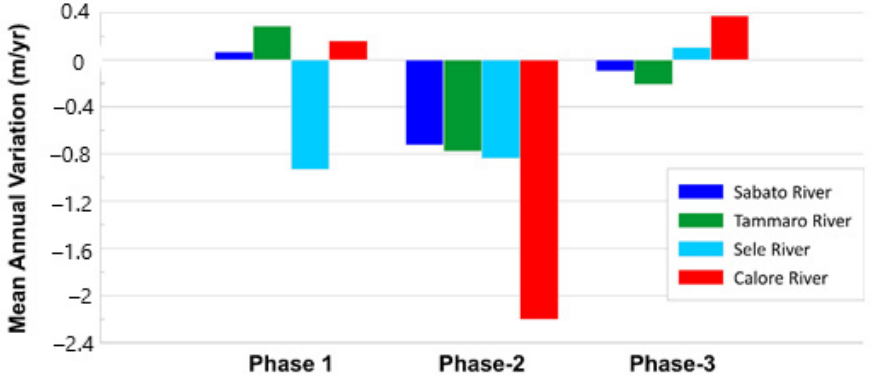
Figure 4. Channel width mean annual variation (MAV) of the investigated rivers in the detected phases.